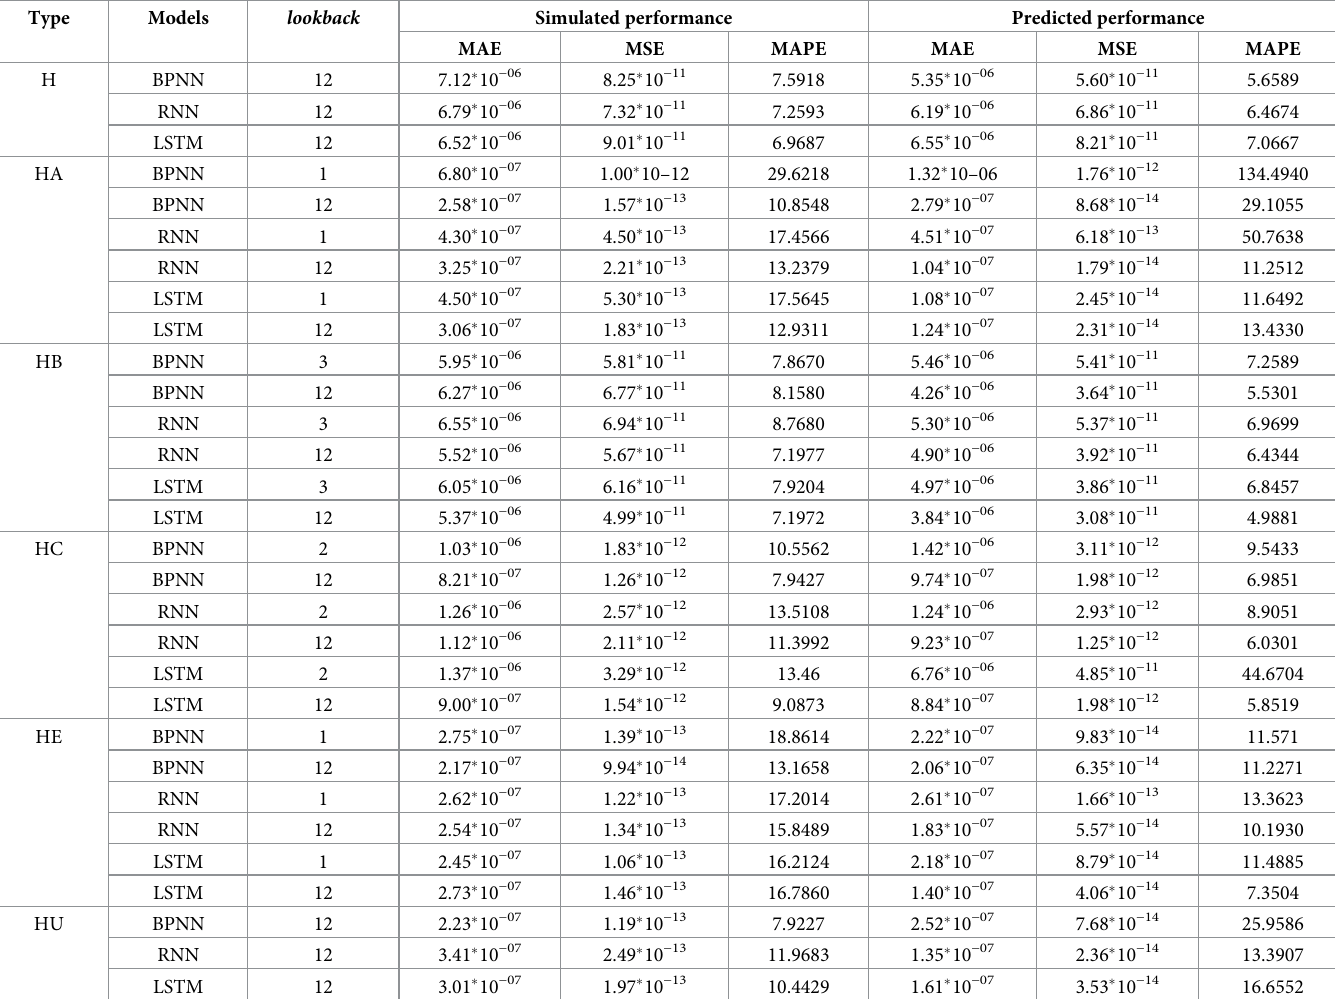
Table 3. Comparison among different